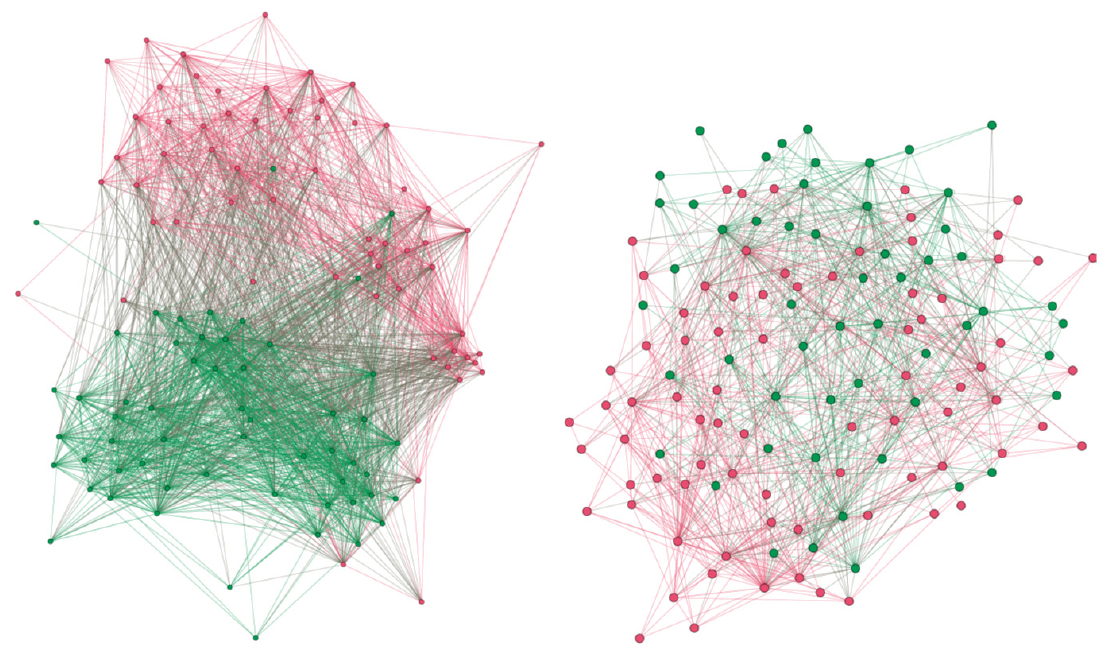
Figure 1. Mentions between left–right Catalan MPs (left network) and between left–right Dutch MPs (right